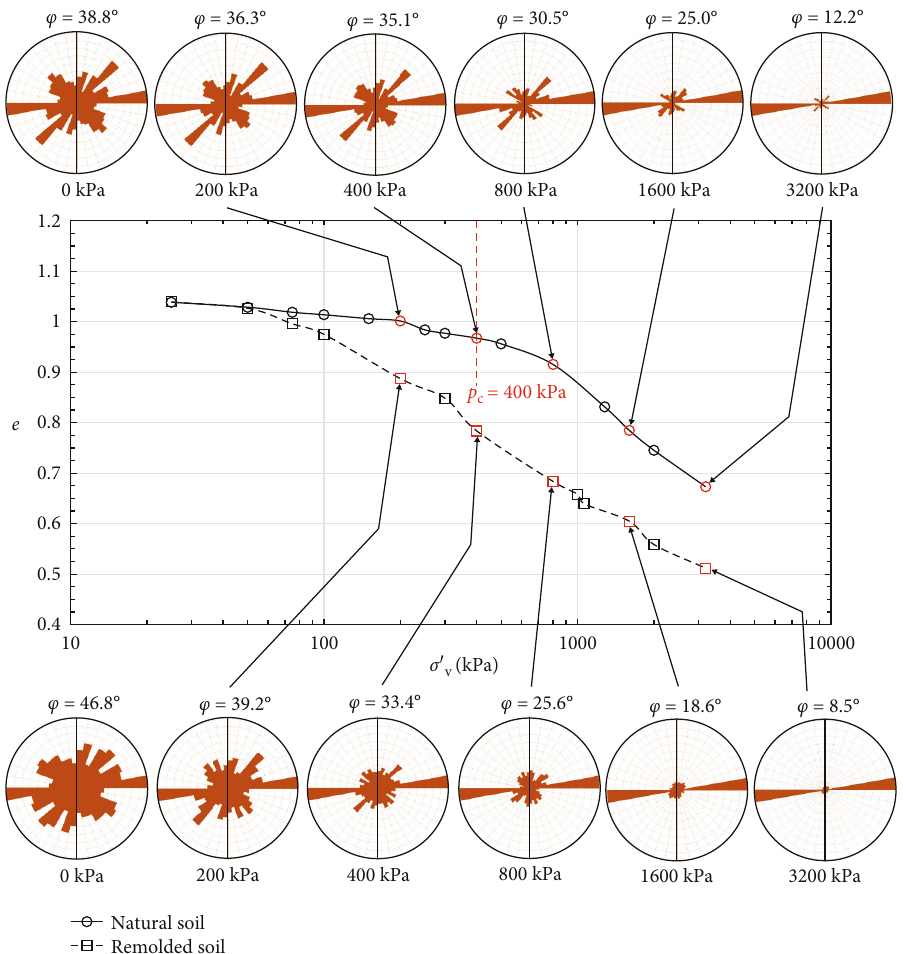
Figure 9: Rose diagrams of particle orientation of natural and remolded GRS at di ff erent compression